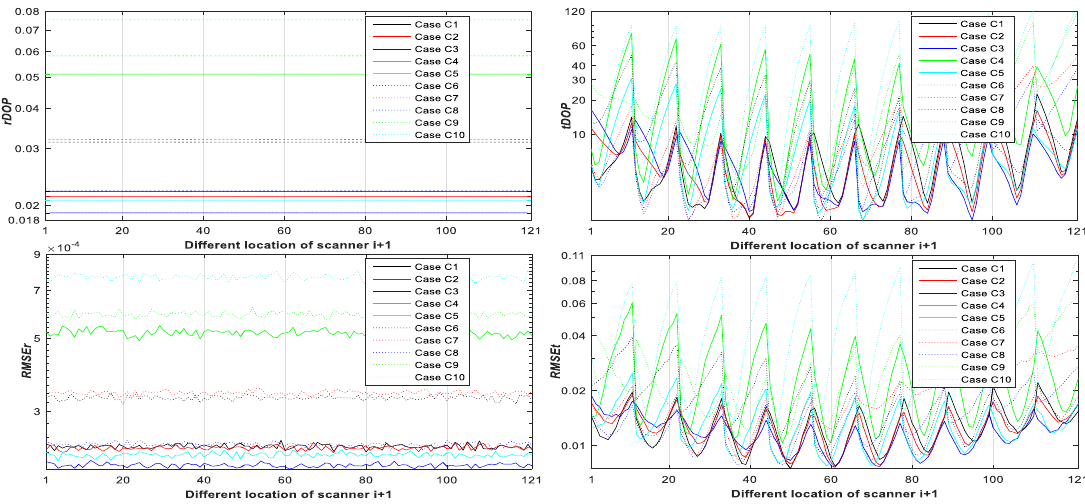
Figure 8. rDOP 6 , tDOP 6 , RMSE r ,6 , and RMSE t ,6 of Case C1–10 with respect to di ff erent scanner i + 1 RMSE , and RMSE of Case C1 – 10 with respect to different Figure 8. 6 rDOP , 6 tDOP , ,6 r ,6 t scanner i + 1 .